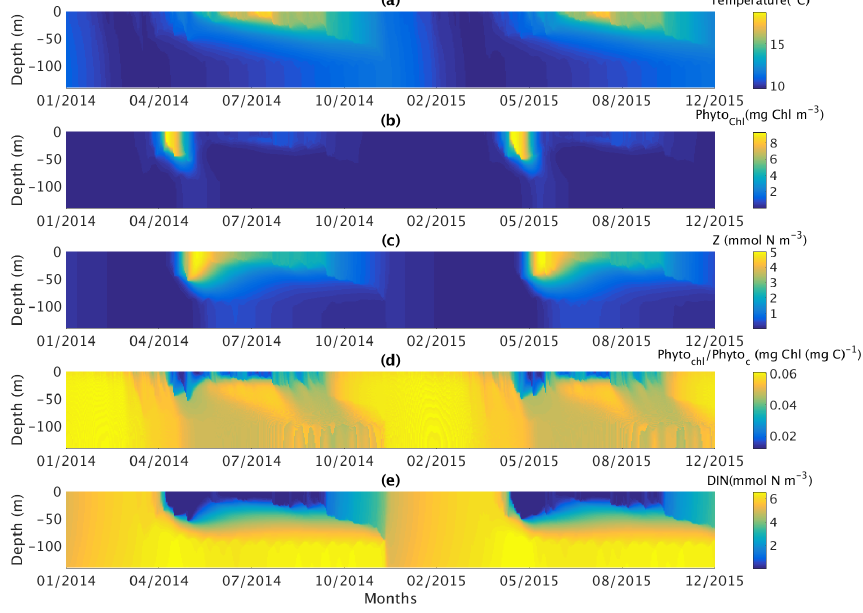
Figure 6. Contoured daily vertical profiles for the start of 2014 to the end of 2015 for the calibrated version of the S2P3 v8.0 model including (a) temperature ( ◦ C), (b) phytoplankton chlorophyll a (mgChlm − 3 ), (c) zooplankton biomass (mmolNm − 3 ), (d) phytoplankton chlorophyll:phytoplankton carbon ratio (mgChl(mgC) − 1 ), and (e) DIN (mmolNm − 3